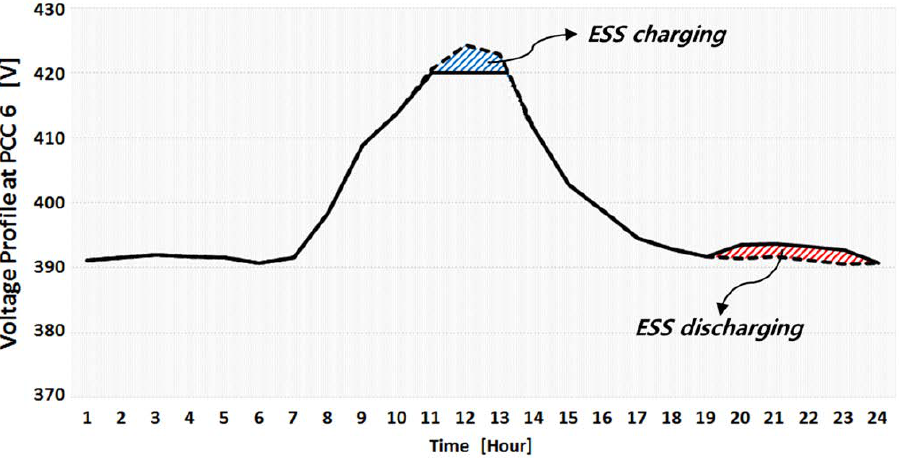
Figure 13. Voltage compensation by using the ESSs.